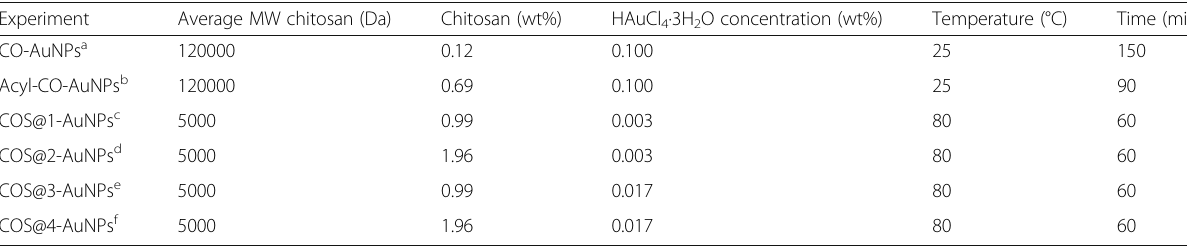
Table 1 Parameters used in AuNP synthesis for each experiment